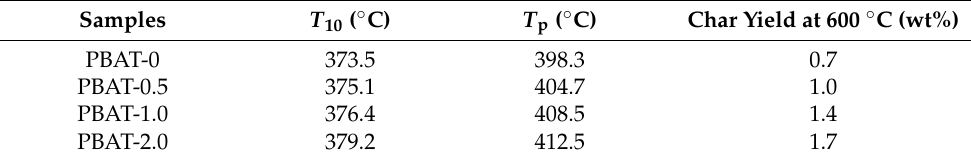
Figure 2. TGA curves of PBAT/Ti 3 C 2 T X nanocomposites at air atmospheres. ( a ) TGA and ( b ) DTG. Table 1. Thermal stability of PBAT/Ti 3 C 2 T X nanocomposite